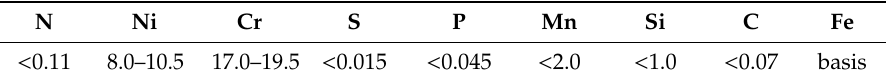
Table 1. Chemical composition of X5CrNi18-10–1.4301 steel, weight